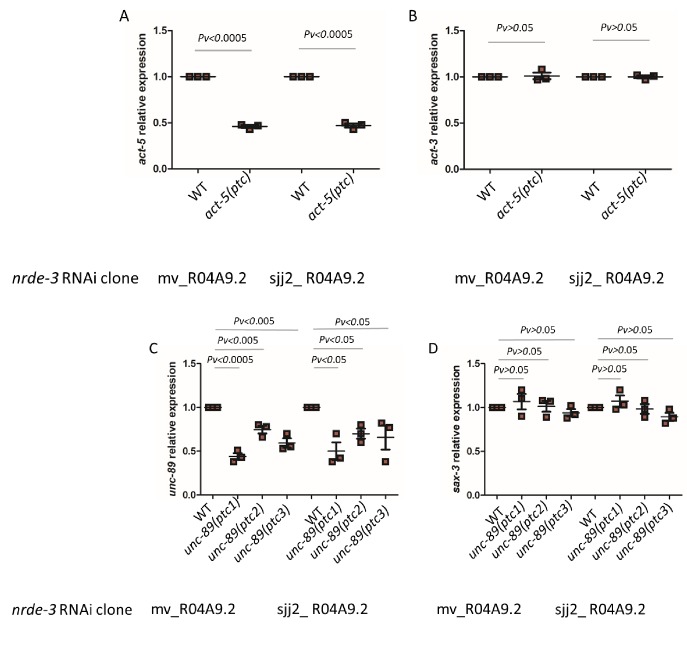
qPCR analysis of act-5 (A) and act-3 (B) mRNA levels in WT and act-5(ptc) mutants as well as of unc-89 (C) and sax-3 (D) mRNA levels in WT and unc-89(ptc) mutants upon nrde-3 RNAi-mediated knockdown by two independent clones.WT expression levels are set at 1. Data are mean ± S.E.M.; average dCt values are shown in Figure 4—source data 1. Two-tailed Student’s t-test was used to calculate P values.